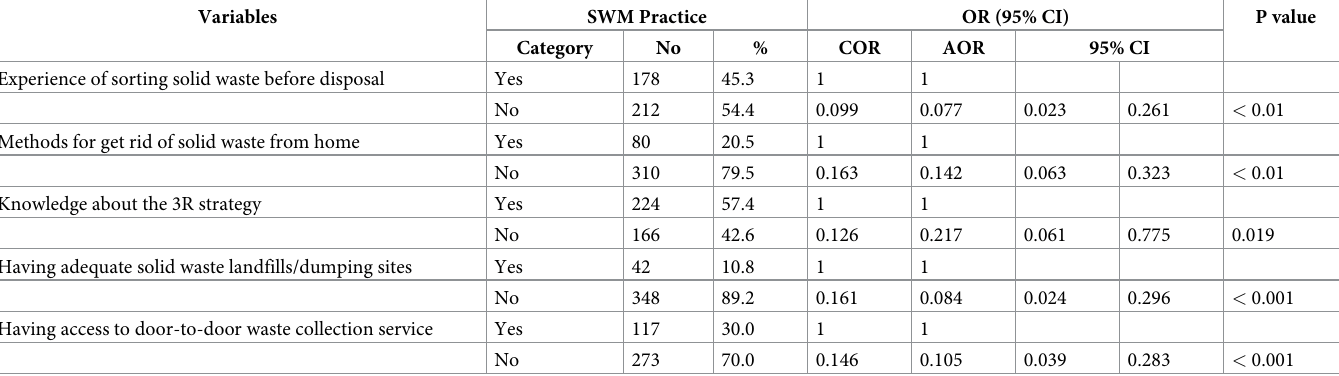
Table 5. Bivariate and multivariate analyses of factors associated with SWM practice in Gelemso town. Variables SWM